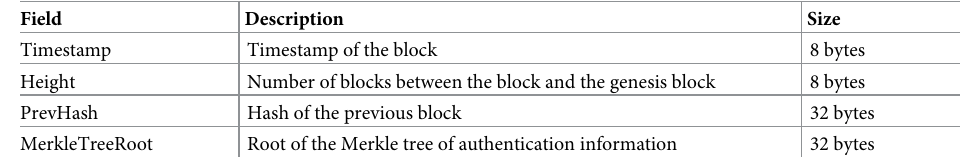
Table 1. Fields of the block